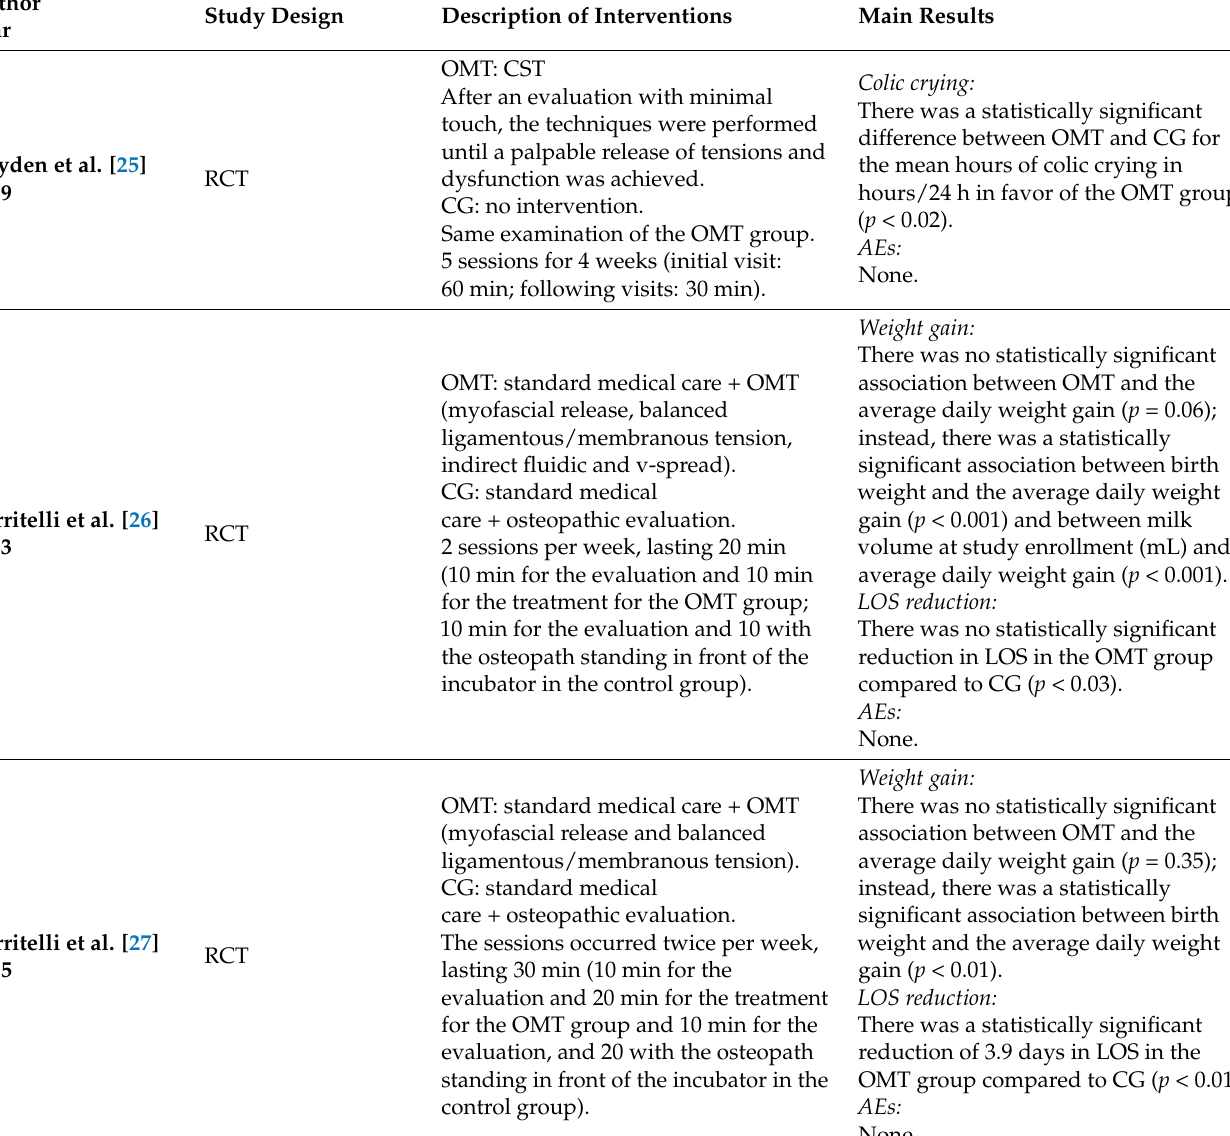
Table 2. Description of interventions and main results of the included